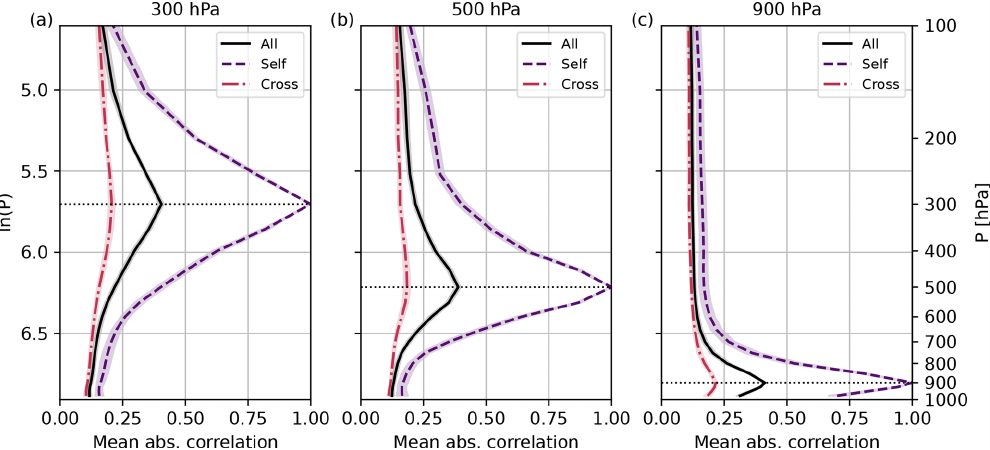
Figure 7. Domain mean absolute 1000-member (true) vertical correlations for different variable combinations (self, cross, and all): reference levels (a) 300hPa, (b) 500hPa, and (c) 900hPa. Mean and standard deviation over 10 forecasts from 29 May to 2 June 2016. Note that the standard deviations are small and hardly distinguishable from the curves